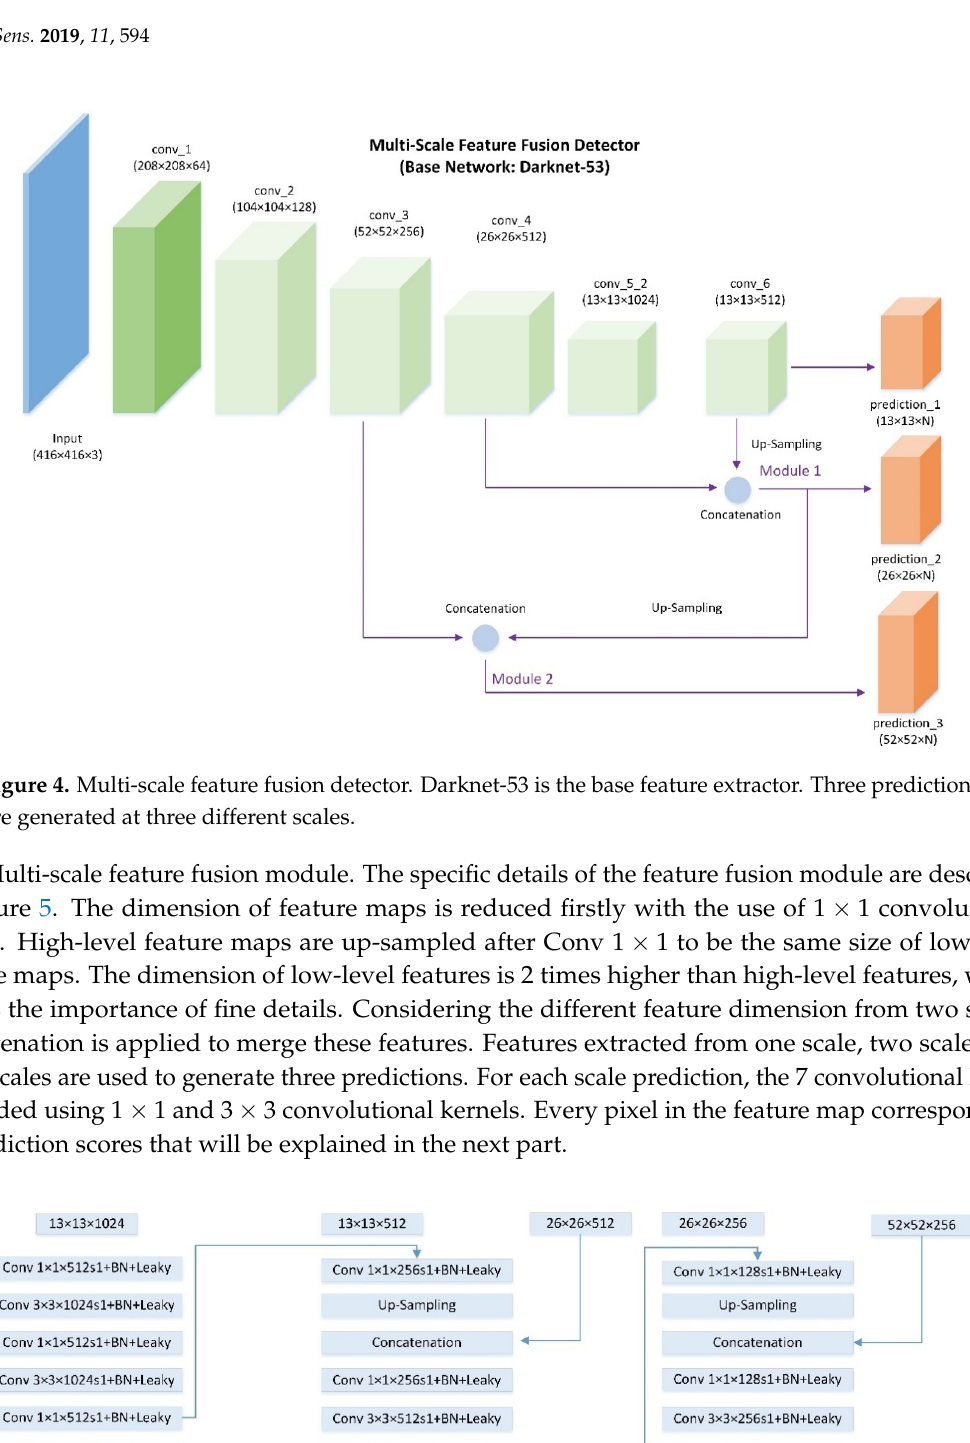
Figure 5. Multi-scale feature fusion module. Feature maps from different layers are merged through up-sampling and concatenation operations, which then predict object detections. Each convolutional layer is followed with a batch normalization (BN) layer and a Leaky ReLU layer. The stride of convolution is 1 (s1).